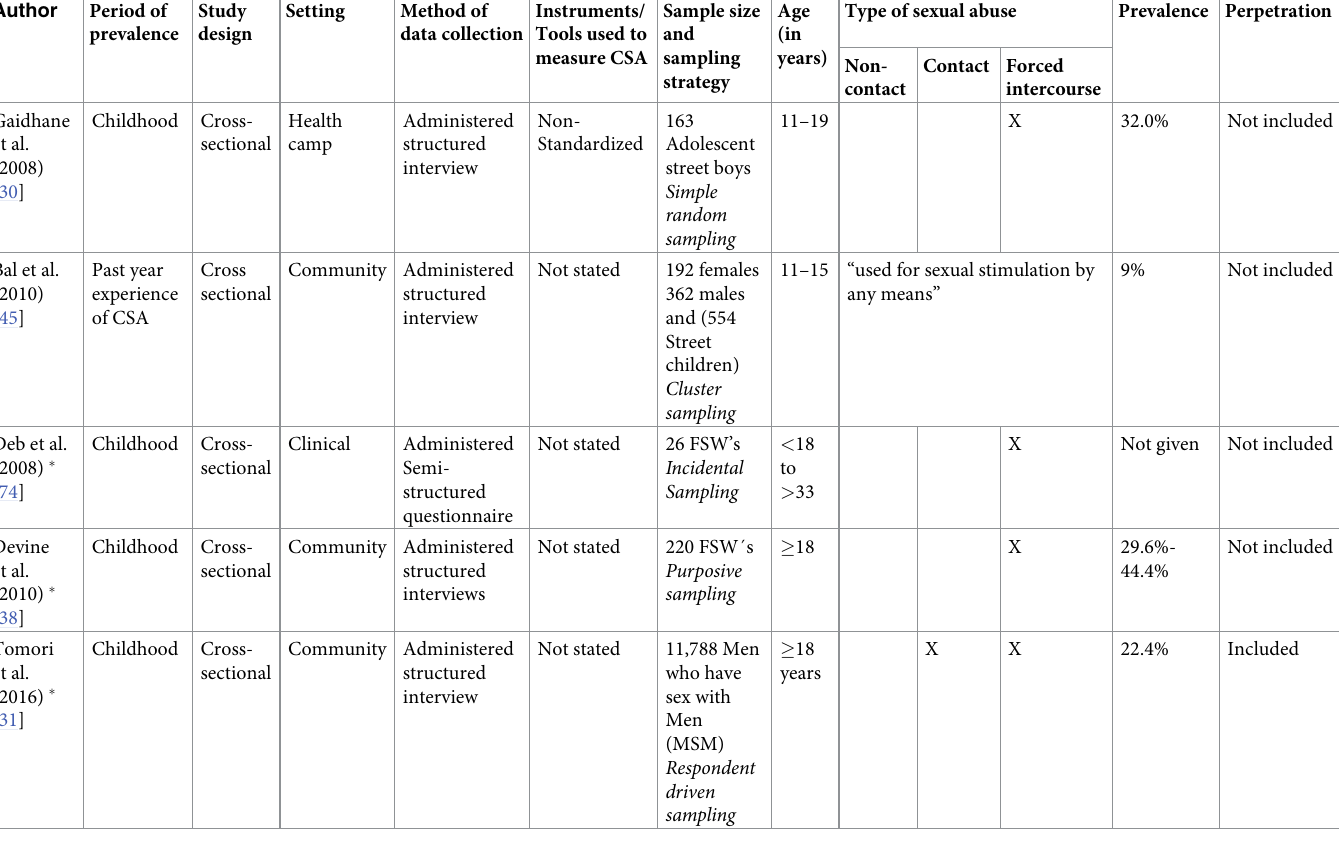
Table 8. Characteristics of quantitative and mixed-method studies included in the review with populations at